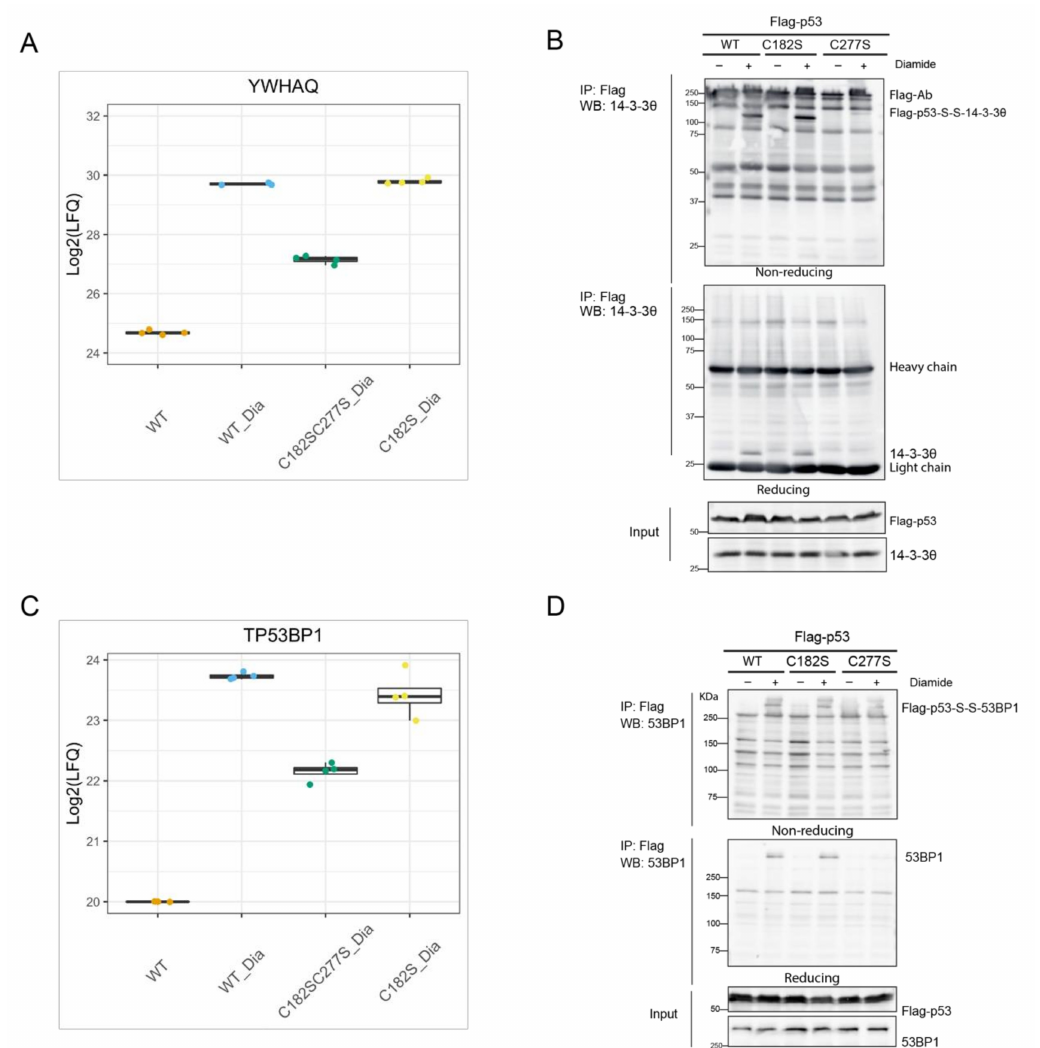
Figure 4. Validation of disulfide-dependent binding partners of p53. ( A ) Comparison of the LFQ values of the YWHAQ gene product (encoding the 14-3-3 θ protein) in different conditions. ( B ) Validation of the disulfide-dependent interaction between p53 and 14-3-3 θ by IP followed by WB. ( C ) Comparison of the LFQ values of the TP53BP1 gene product (encoding the 53BP1 protein) in different conditions. Note that the TP53BP1 gene product was not found in any of the replicates of the untreated condition (WT) and a missing value (NA) was observed upon Log2 transformation. This was manually imputed by a value of 20(Log2) (near to the lowest value in the whole dataset) during data analysis. ( D ) Validation of the disulfide-dependent interaction between p53 and 53BP1 by